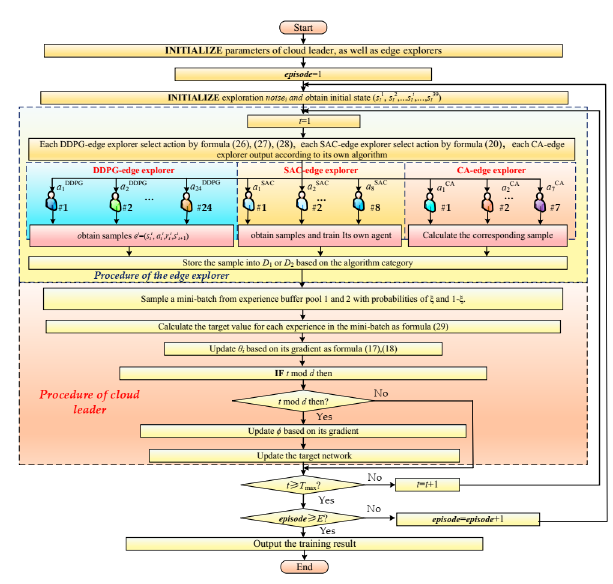
Figure 4. ECMTD-DDPG algorithm flow